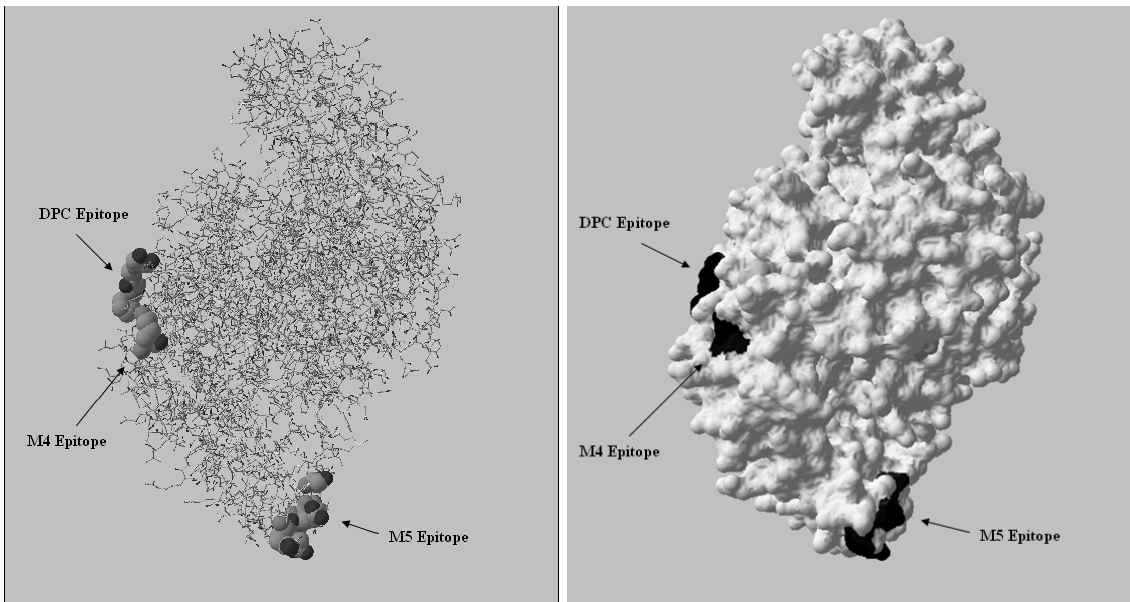
Figure 10: Location of some epitopes on the GAD 65 molecule. Left image: The residues of the epitopes are rep- resented by the van-der-Waals radii of their atoms. Right image: The protein is represented by the molecular sur- face and the locations of the epitopes are mapped on the surface and encoded in black. The visualization of epi- topes in the GAD 65 molecule gives insights into mechanisms of antigenicity.